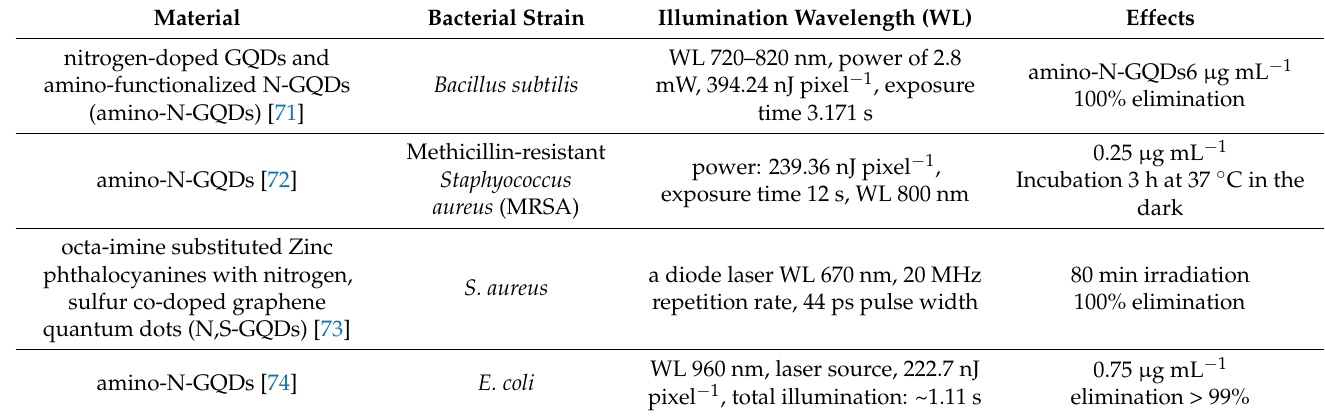
Table 6. Studies regarding GQDs with N in structure and its antibacterial photodynamic